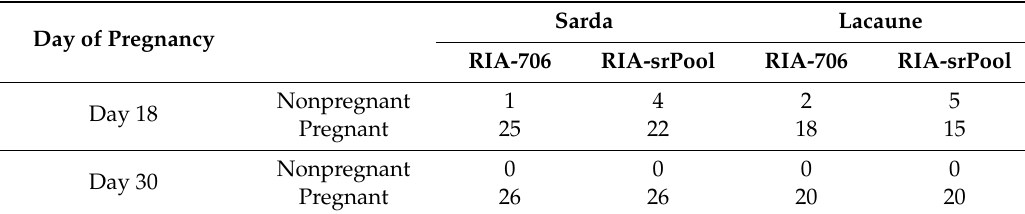
Table 2. PAG detection (cut-o ff ≥ 1 ng / mL) in Sarda and Lacaune ewes according to RIA method (RIA-706 vs. RIA-srPool) at day 18 and day 30 of pregnancy. Sarda Lacaune Day of Pregnancy RIA-706 RIA-srPool RIA-706 RIA-srPool Nonpregnant 1 4 2 5 Day 18 Pregnant 25 22 18 15 Nonpregnant 0 0 0 0 Day 30 Pregnant 26 26 20 20